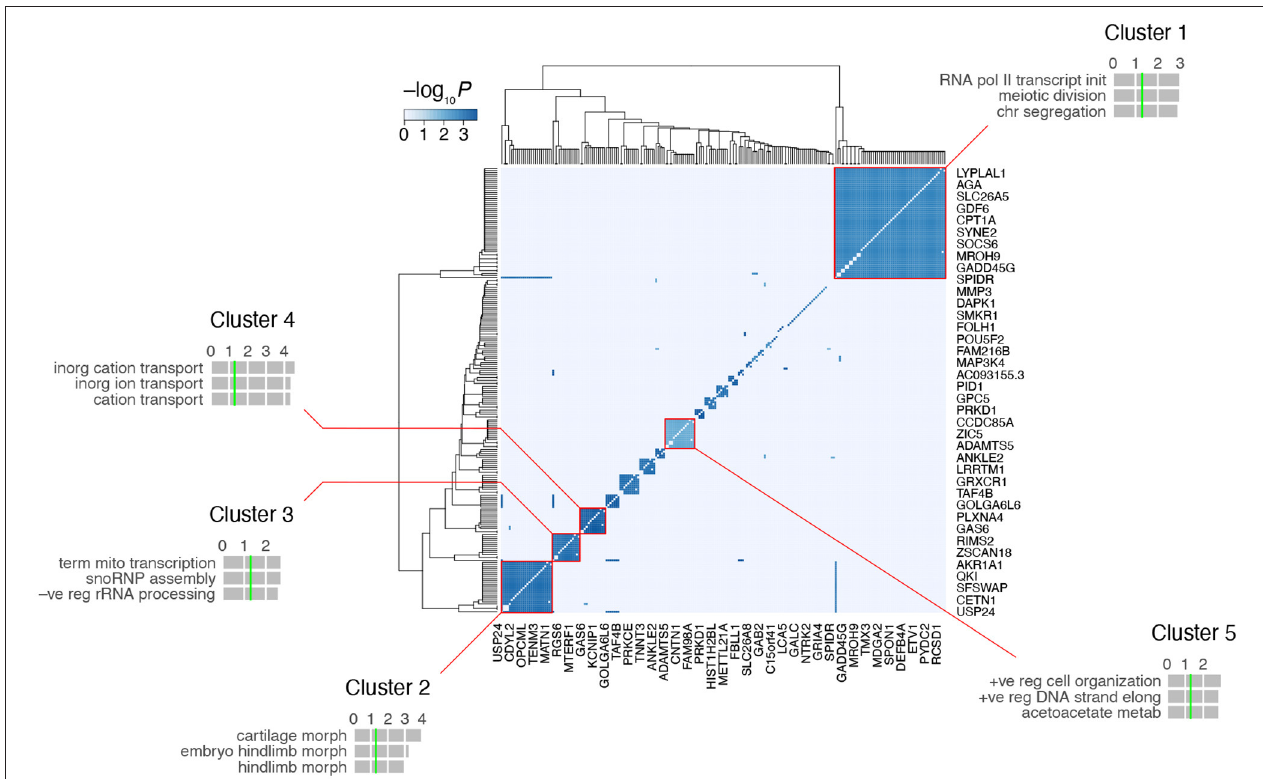
FIGURE 5 | Clustering of the RH-Seq network. The five largest clusters are highlighted, together with the top three GO biological process terms for each cluster. Horizontal gray bars, GO − log 10 P -values; vertical green lines, P = 0.05 (all FDRs > 0.05). The entire network is shown, but space only allows labeling of ∼ 1 3rd of the 225